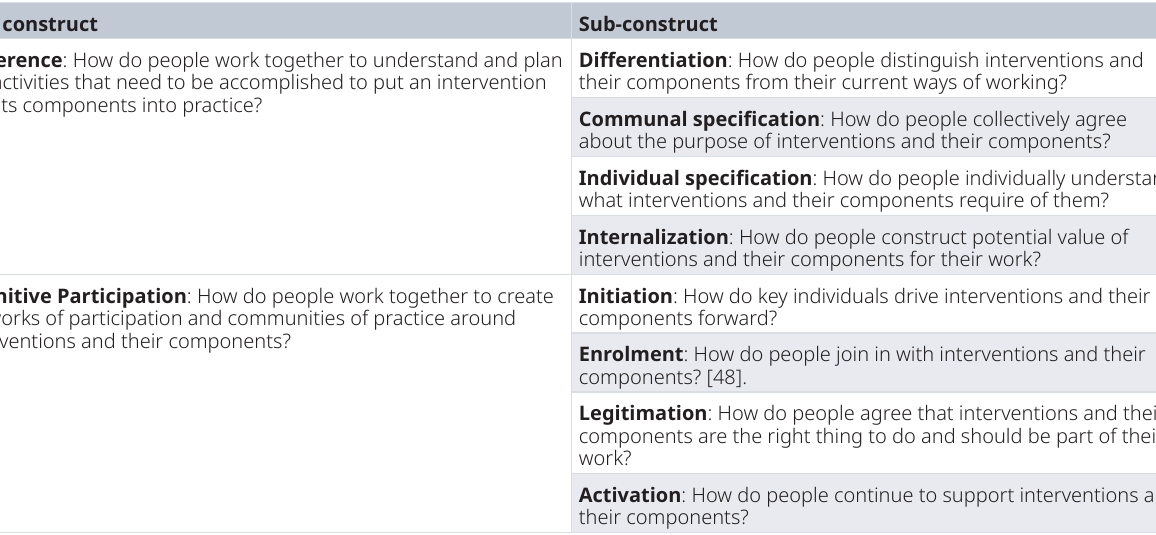
Table 3. NPT coding manual part B: Granular codes for implementation mechanisms 12 . NPT